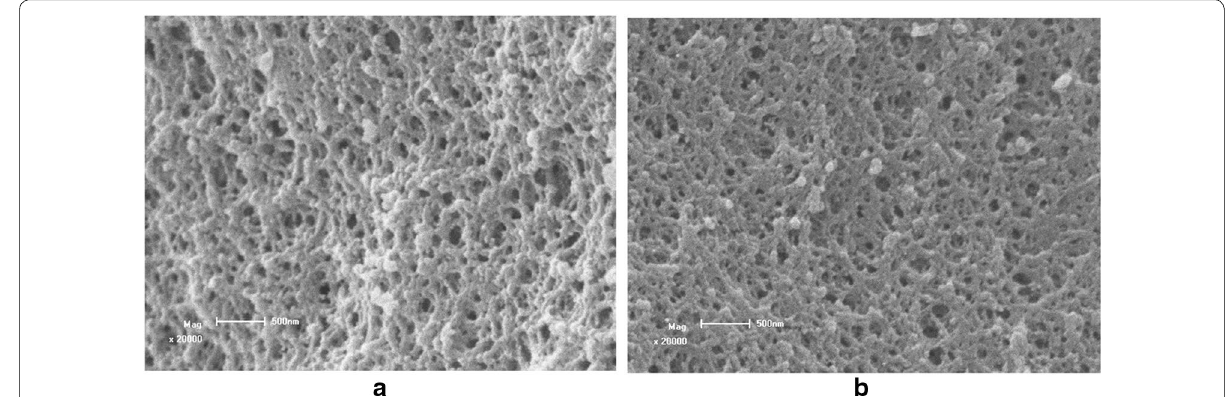
Fig. 2 Scanning electron micrographs of the MIPs ( a ) and NIPs ( b